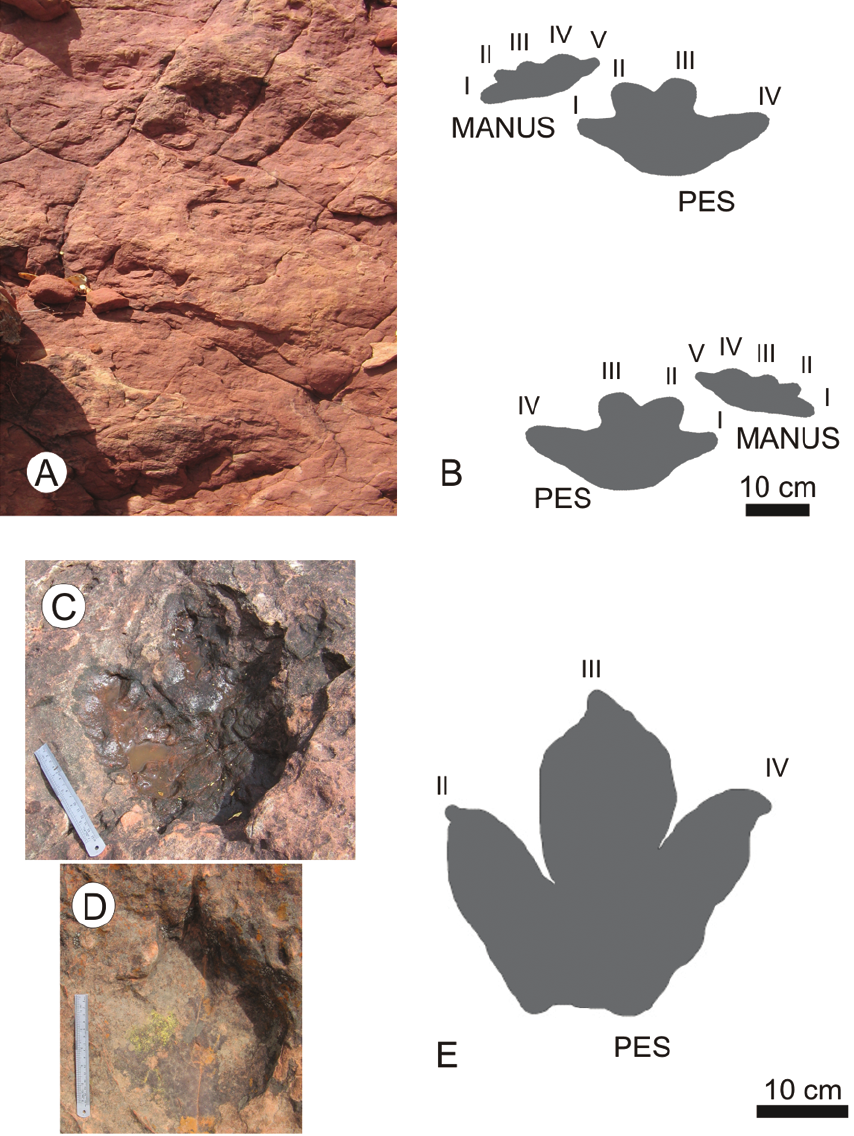
Fig. 5 – Ichnotaxon D. Trackway (A) and scheme with distances preserved (B). Ichnotaxon E. Track (C, D) and detailed scheme